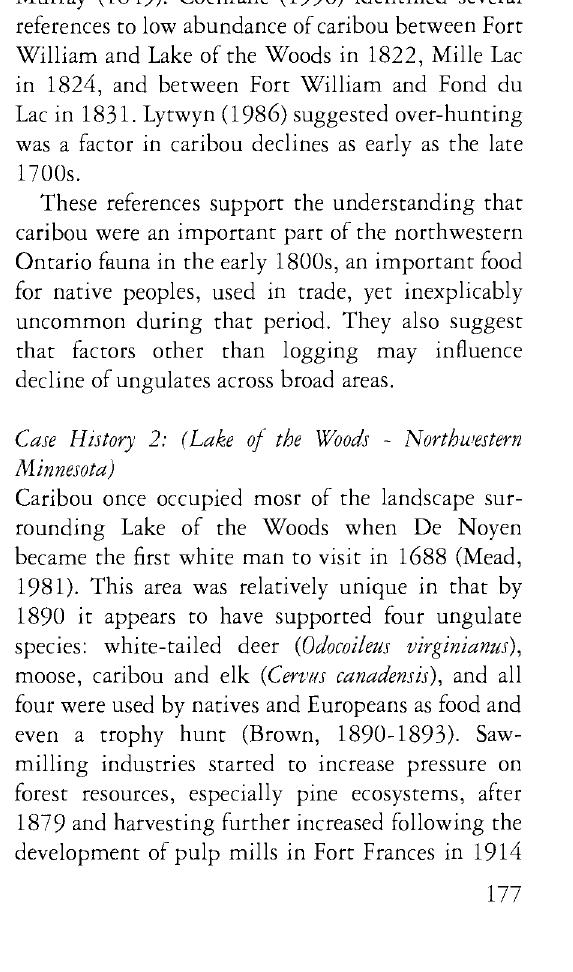
Fig. 3. Coarse mapping of woodland caribou winter habitat utilization and major calving areas for the current com mercial forest of northwestern